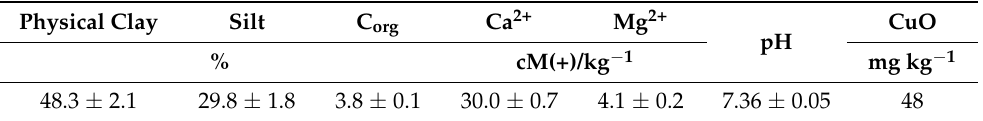
Table 1. Physical and chemical properties of Haplic